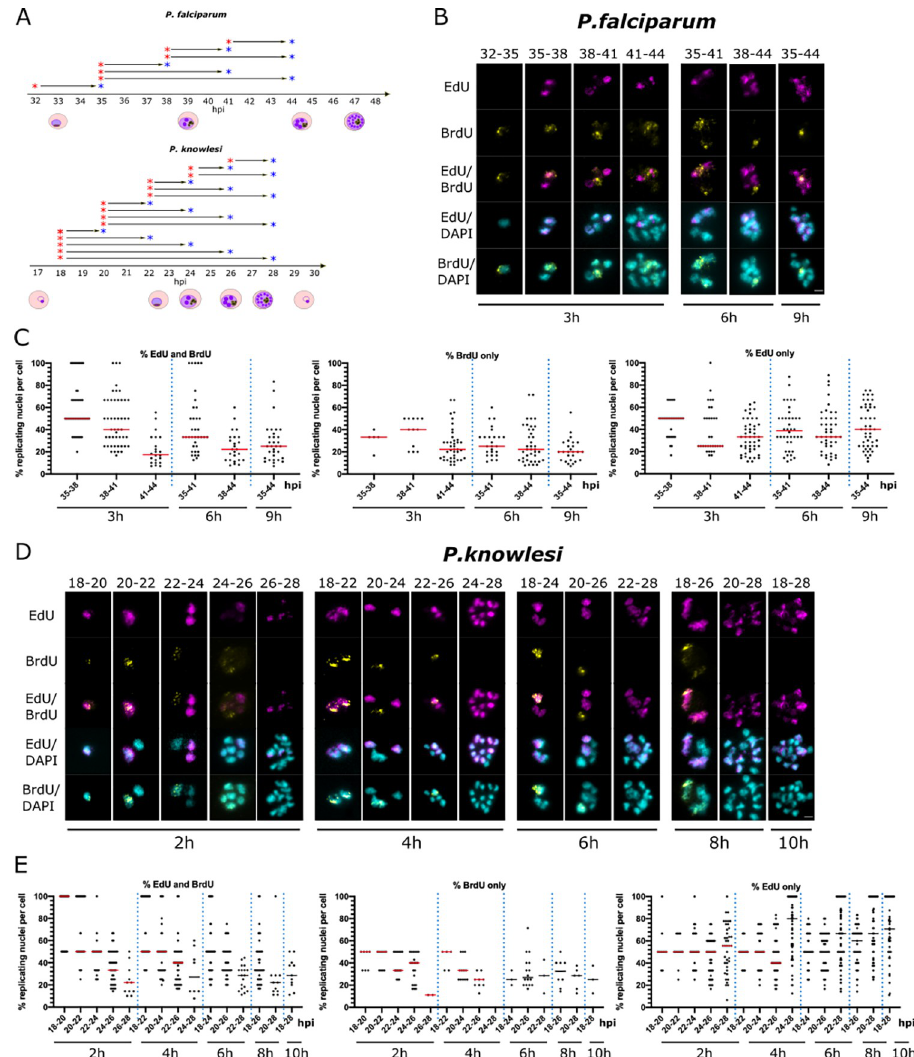
Fig 5. Gap phases lengthen across the course of schizogony. A: Schematic of the timecourses shown in this figure. B, D: Representative examples of cells across double-labelled timecourses for P . falciparum (B) and P . knowlesi (D). P . falciparum was labelled at 3h intervals, up a maximum of 9h (35-44hpi); P . knowlesi at 2h intervals, up a maximum of 10h (18-28hpi). Scale bars all panels 2 μ m. C,E: Percentages of nuclear masses per cell labelled with EdU and BrdU, EdU alone, or BrdU alone throughout each timecourse. Dotted lines separate the datasets from different time- intervals. Medians are shown in red.